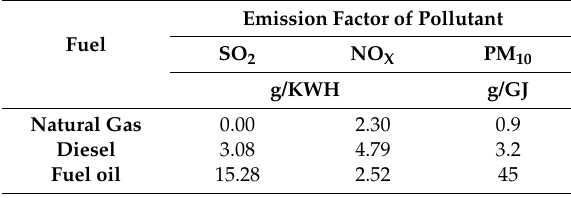
Table 1. Average emission factors of SO 2 , NO X, and PM 10 depending on fuel